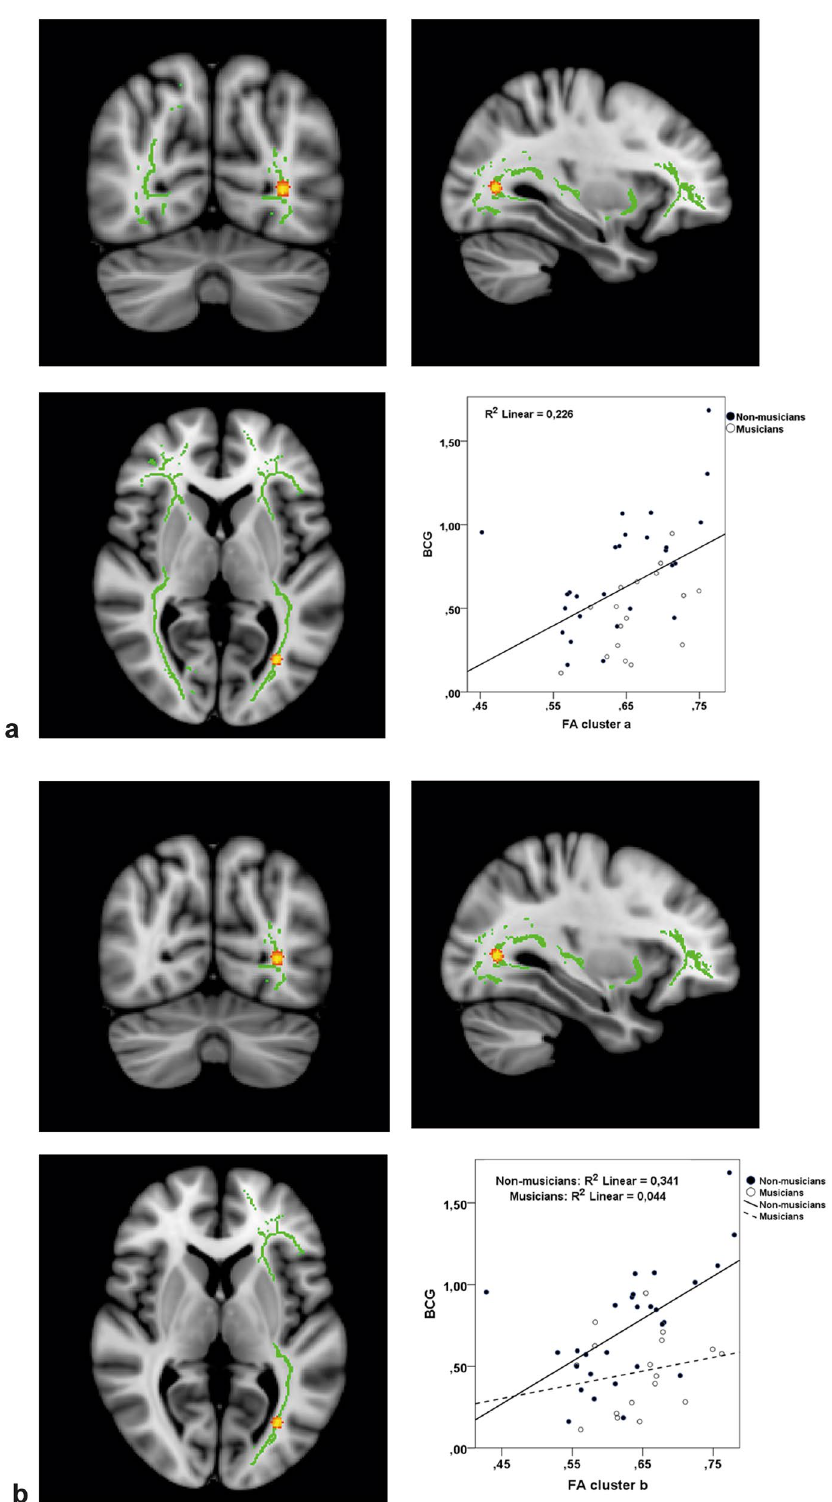
Figure 2. Significant clusters and corresponding scatter plots. ( a ) Across groups. Significant cluster resulting from correlating bimodal compatibility gain (BCG) with the FA value of the ROI mask voxels, using age, gender and group as covariates. The scatterplot shows a positive correlation in this area. Threshold-free cluster enhancement was used to control for multiple comparisons with family-wise error (FWE) at alpha < 0.05. ( b ) Separate analyses of musicians and non-musicians with (FWE) at alpha < 0.10. In non-musicians only, a significant cluster was found, which overlapped and was extended in size compared with the original cluster. Musicians are included in the scatterplot, but the brain images depict only